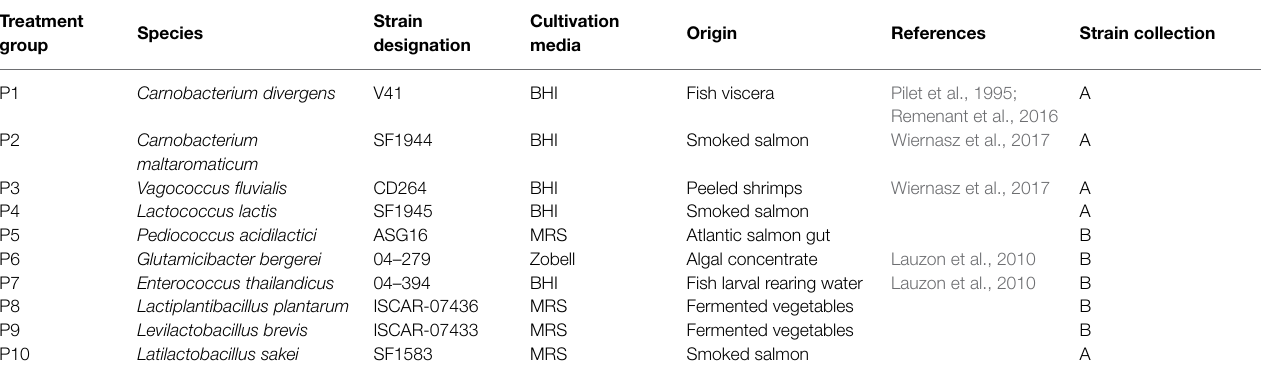
TABLE 1 | List of strains used in the probiotic feeding